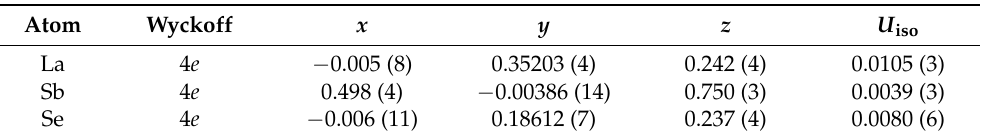
Table 1. Room temperature crystal structure determined by powder XRD. Space group: P 21/ c . a = 4.24437 (17) Å, b = 18.4271 (4) Å, c = 6.0175 (4) Å. β = 134.971 (4)º. R p = 0.023, R wp = 0.032, R exp = 0.349, R ( F ) = 0.060, χ 2 = 0.008.